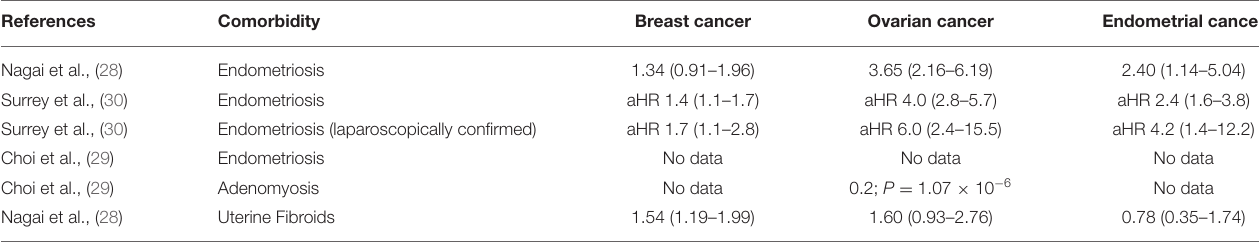
TABLE 3 | Comorbidity of endometriosis or uterine fibroids with breast, ovarian and endometrial